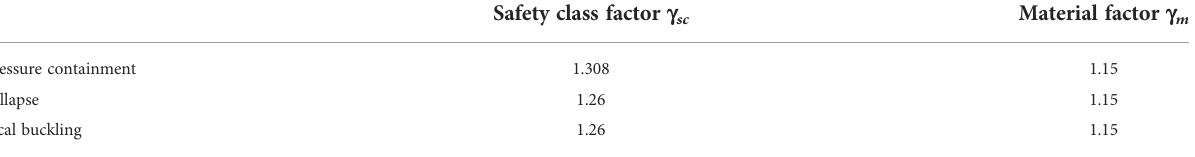
TABLE 4 The applied partial factors determined by the corresponding high safety